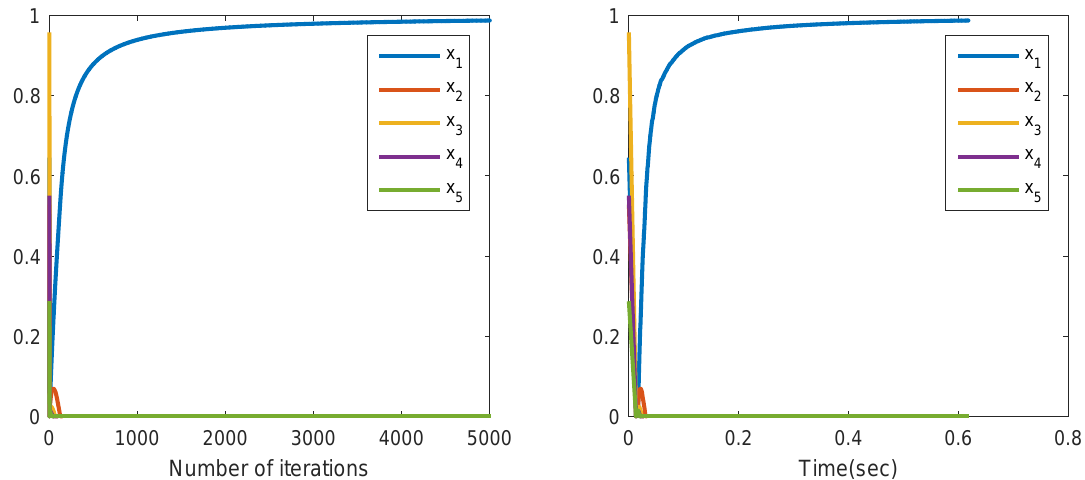
Figure 1. Behaviors of x 1 – x 5 with the number of iterations (resp.) k = 5000. Numerical results for Algorithm 1.